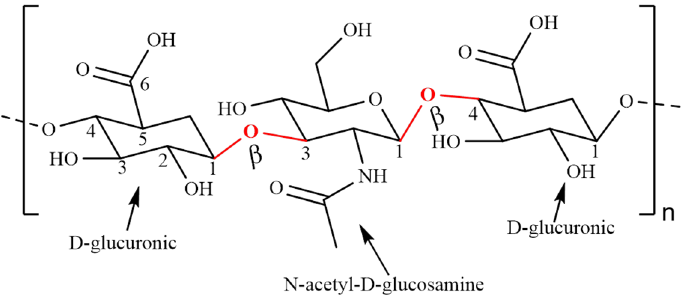
Figure 6. Chemical structure of hyaluronic acid.